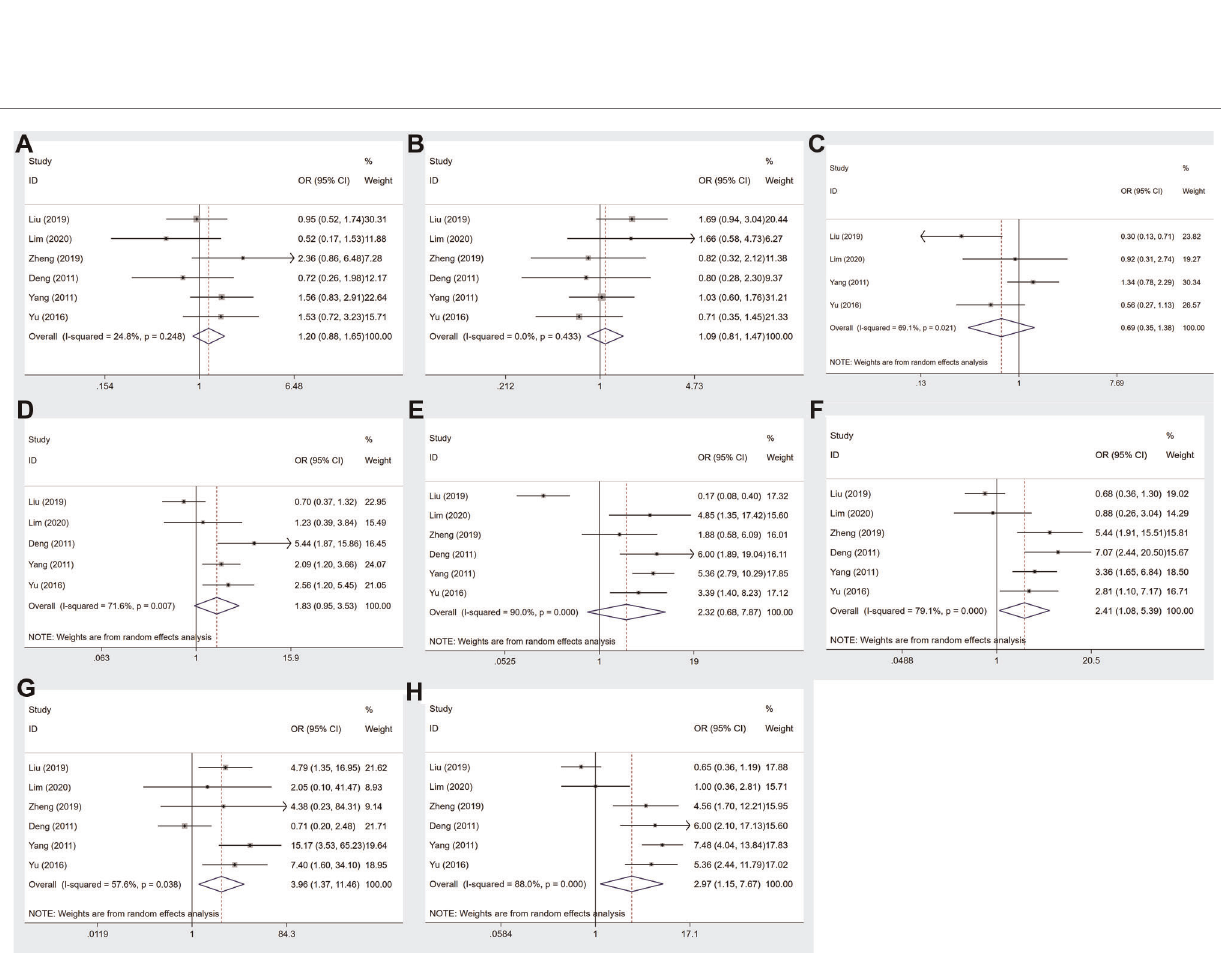
FIGURE 2 | Forest plots and funnel plots for the USP22 expression between GC and control tissues. ( A ) forest plots and ( B ) funnel plots.